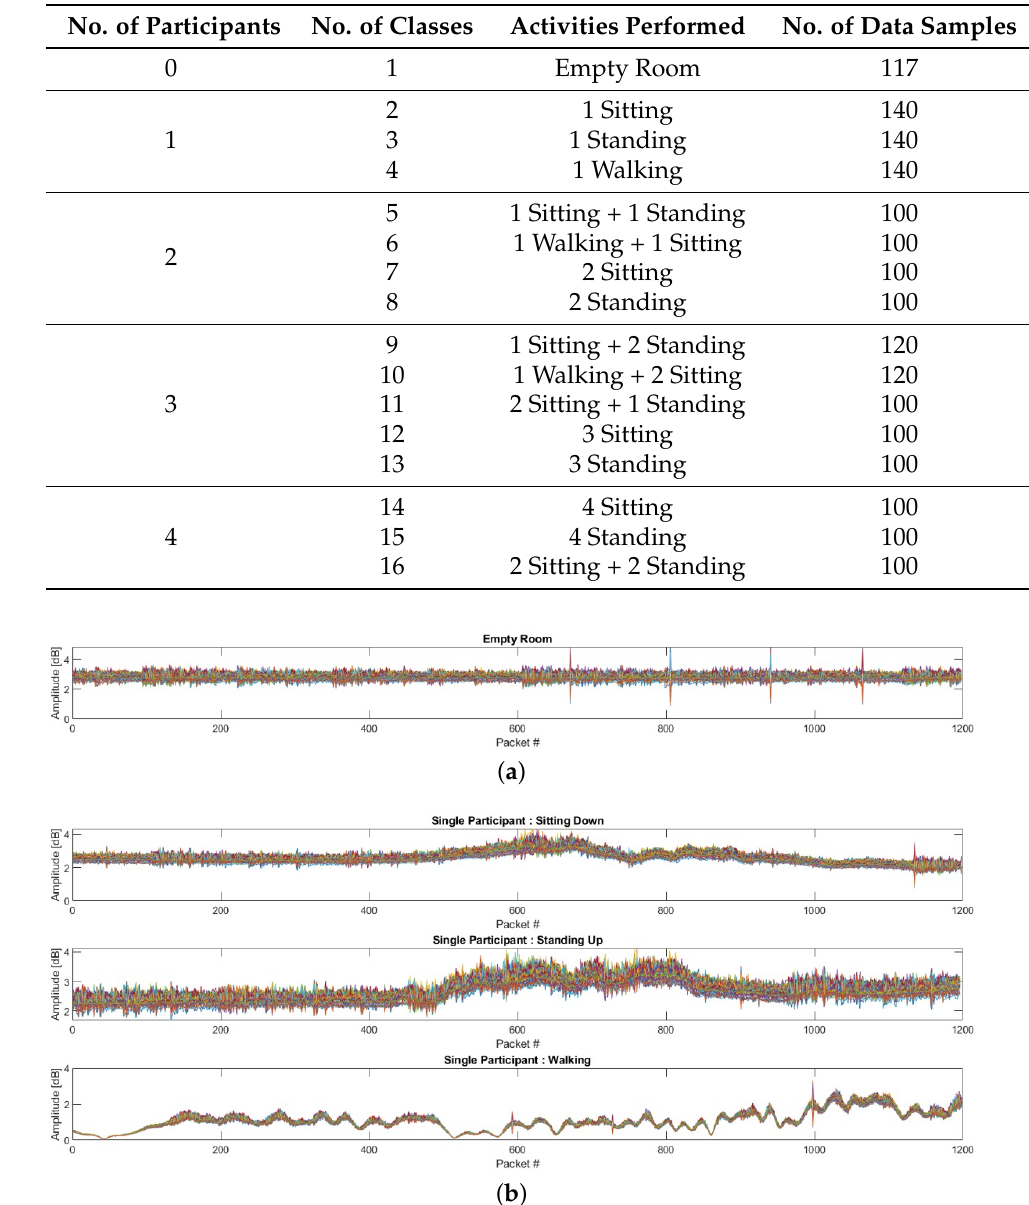
Table 1. Number of participants and performed activities (see Figure 3 for the data samples).